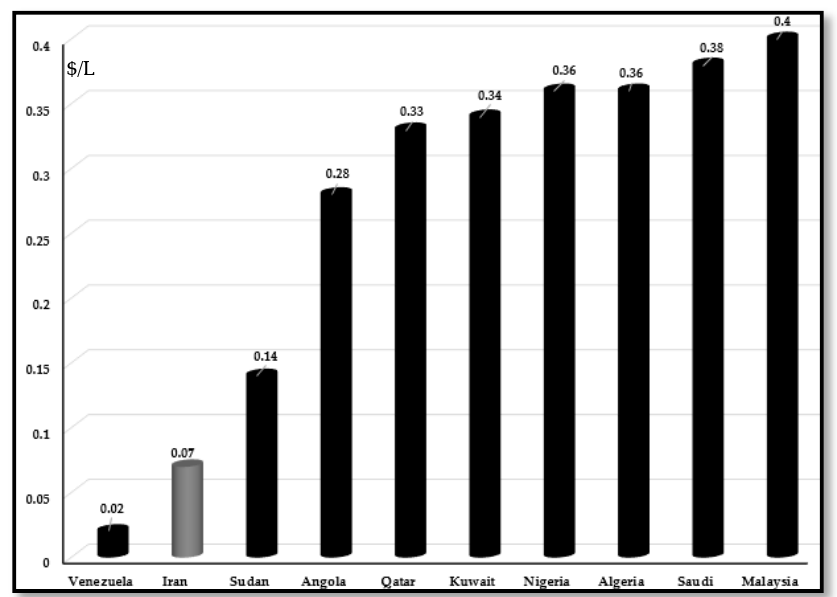
Figure 6. Top ten world’s lowest gasoline price 13 July 2020 [40]. Energies 2020 , 13 , x FOR PEER REVIEW